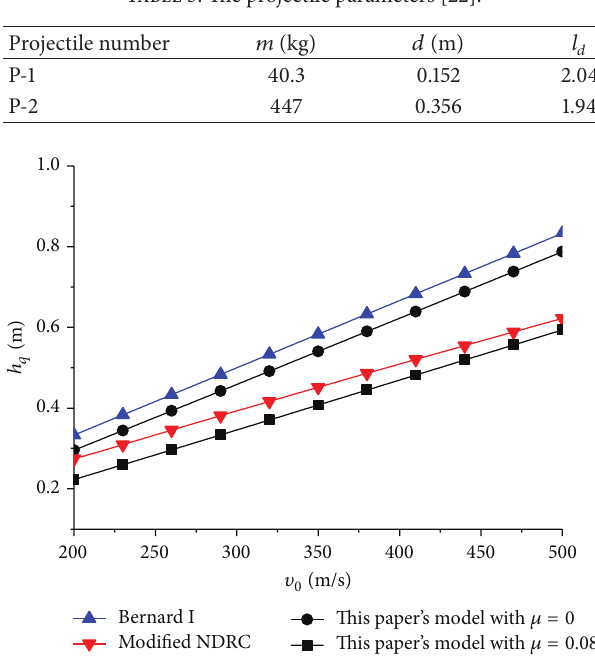
Table 3: The projectile parameters [22].